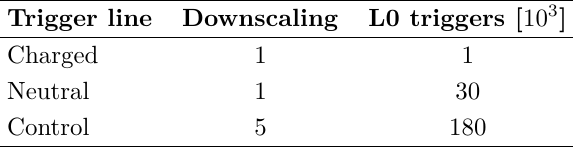
Table 5. List of beam-dump trigger lines, L0 downscaling factors, and numbers of L0 triggers produced per spill at a beam rate of 10 12